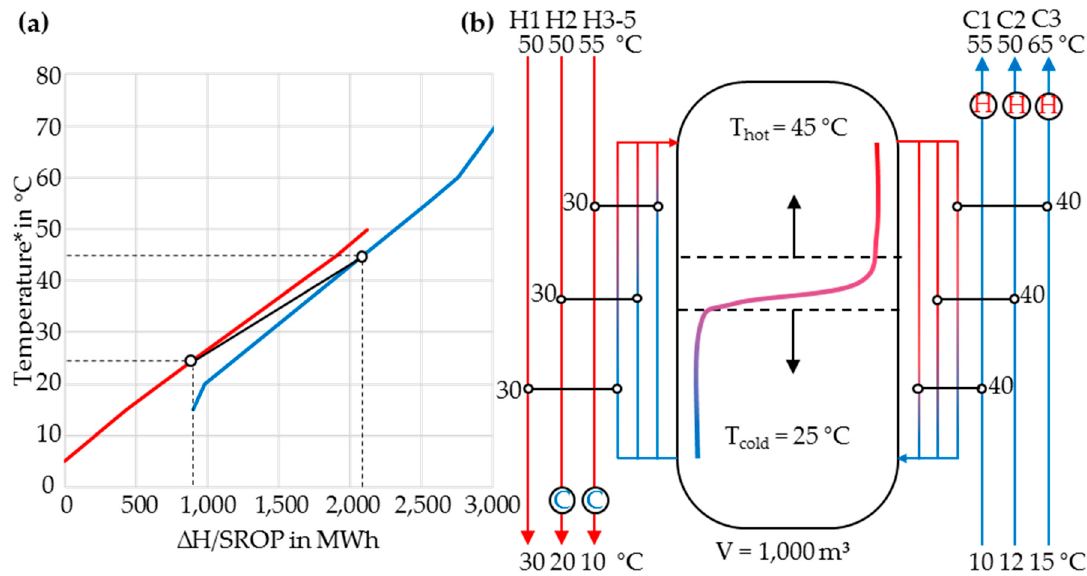
Figure 14. ( a ) Heat recovery potential according to the time average model (TAM) and ( b ) HRL sizing by the ISSP method.